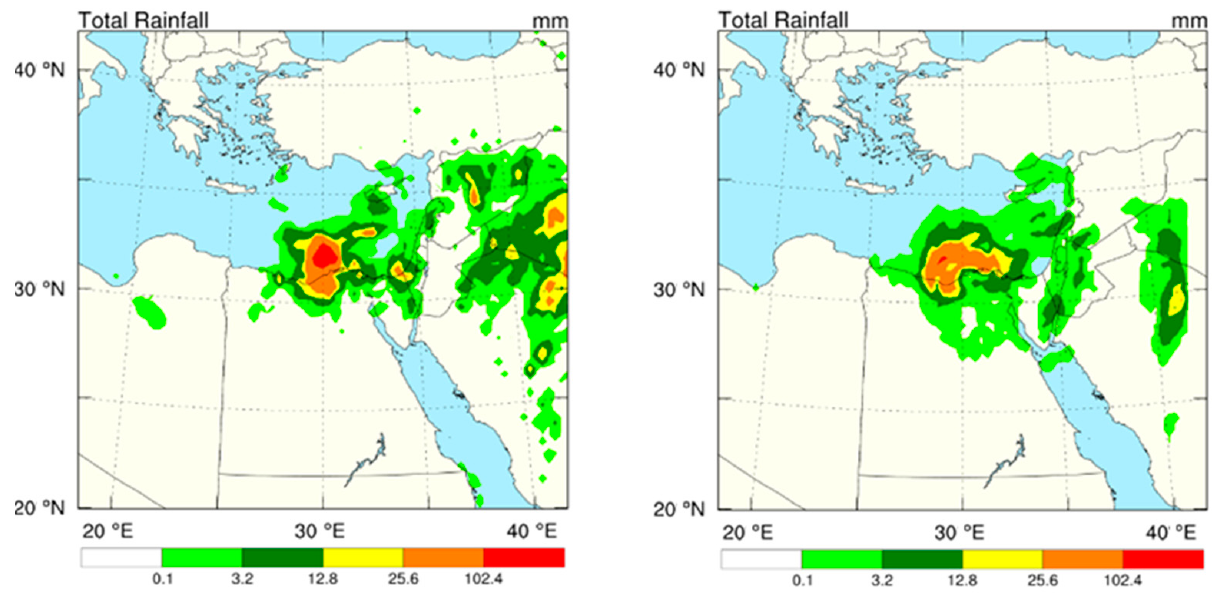
Figure 8. GPM satellite rainfall observations ( left ) and WRF NWP simulations ( right ) for an extreme hydrometeorological event on 4 November 2015. Legend: The two figures show the estimation difference between two approaches.